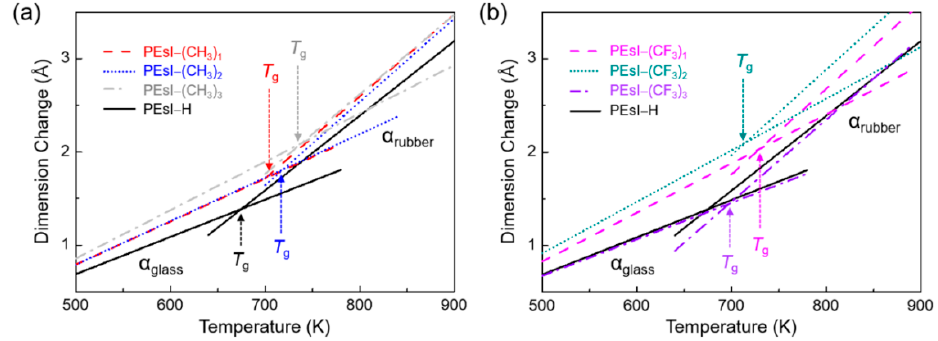
Figure 4. Plots of dimension change versus temperature obtained from molecular dynamics (MD) simulations. ( a ) –CH 3 - and ( b ) –CF 3 -substituted PEsI systems.